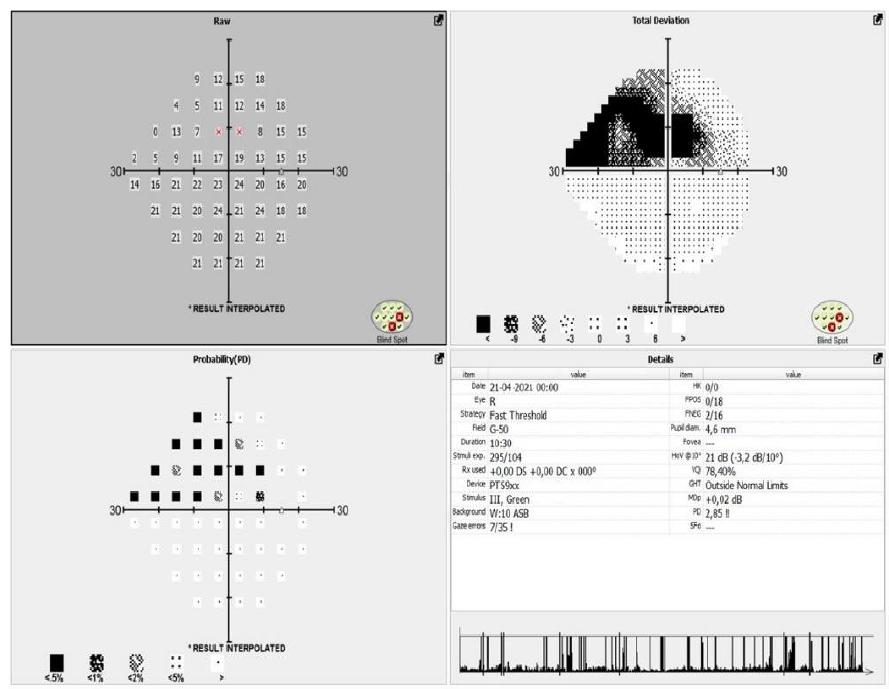
Figure 1. Represents the visual field of a patient with moderate glaucoma before the surgical procedure.